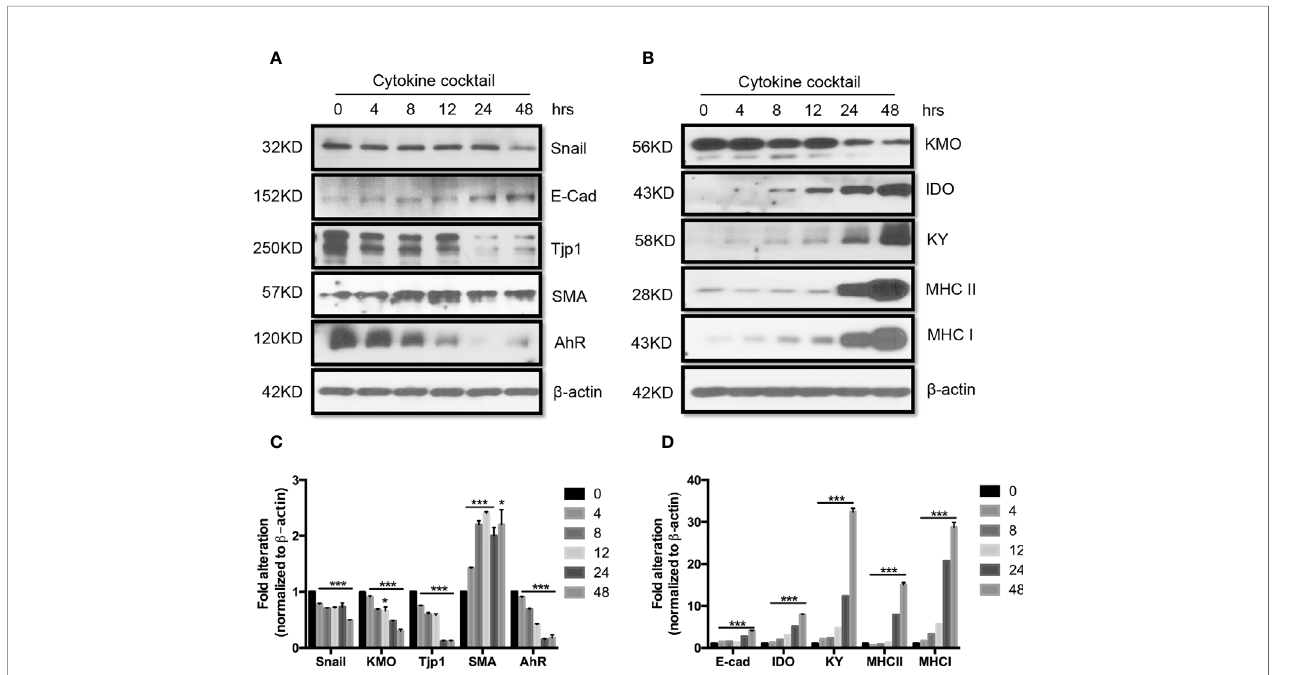
FIGURE 3 | Western blot analysis of function protein expression on primary human renal cortical epithelial cells challenged with cytokines. Primary human renal tubular epithelial cells are challenged with cytokine cocktail (15nM IFN g , 6nM TNF a , and 3nM IL1 b ). (A, B) Expression of Snail, E-Cad, TJP1, SMA. AhR, IDO, KMO, KY, MHCI & II. (C, D) Densitometric quantitation of protein in (A, B) . All Western blots are representative of at least three independent experiments. * P < 0.05, *** P < 0.0001 versus to cells without treatment, analysis is multiple t-tests, pairwise comparison of individual time-point to control indicated same